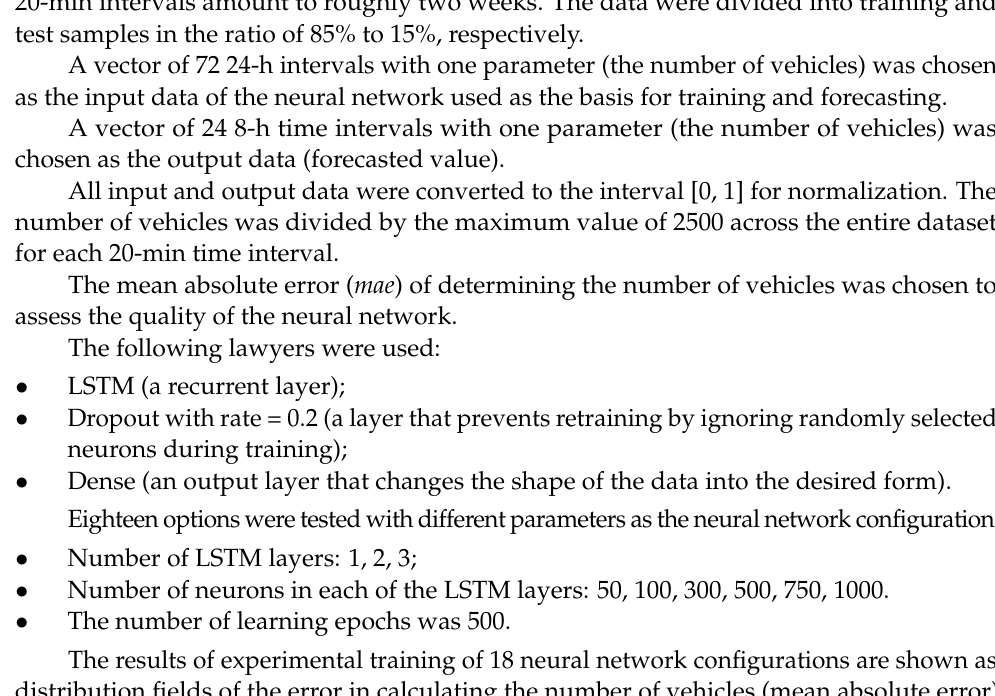
Figure 8. Schematic of an LSTM cell.